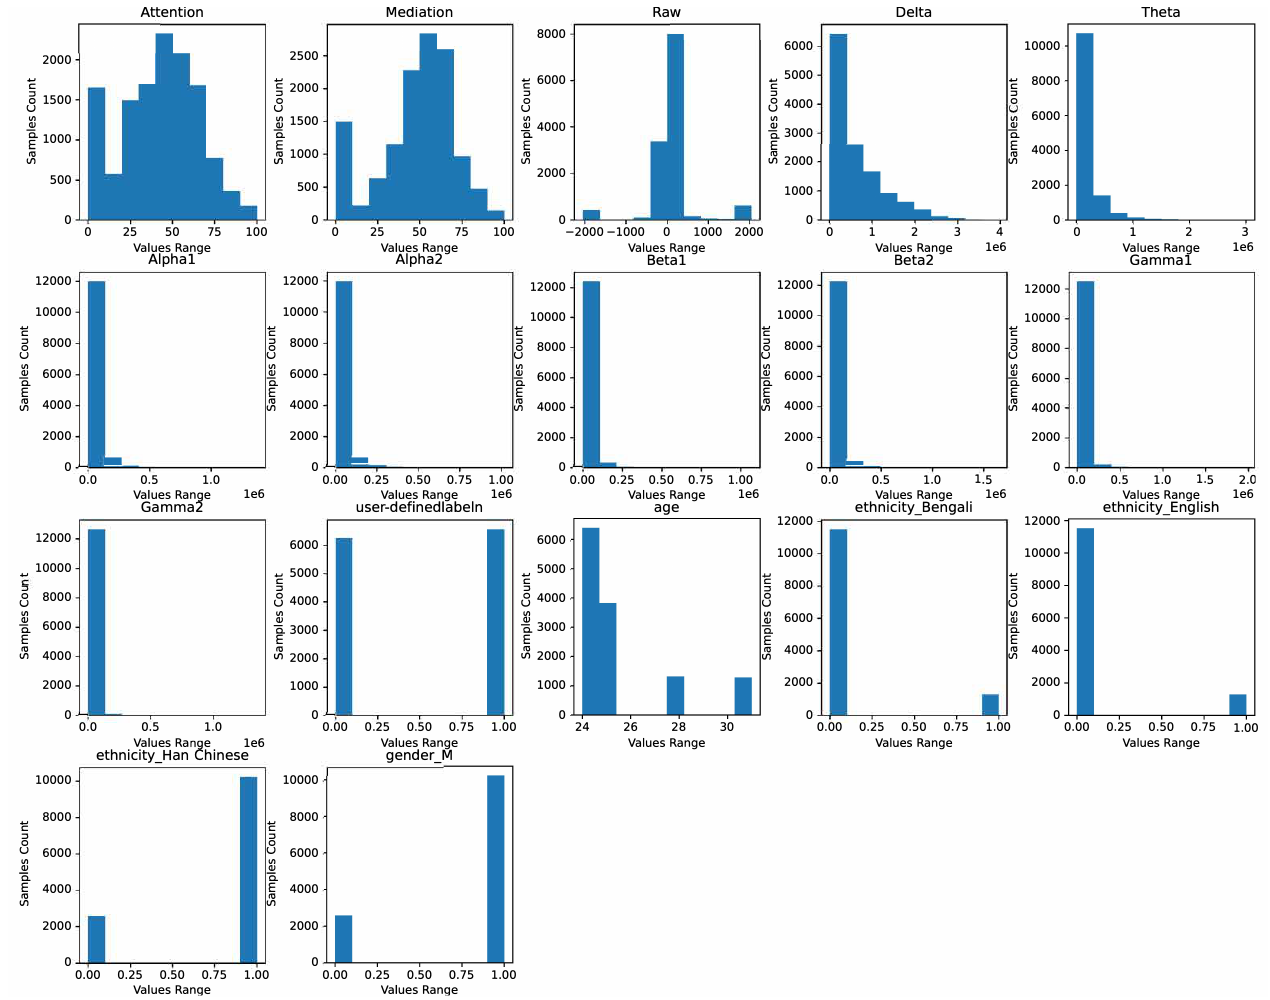
Figure 2. Histogram of EEG dataset features. Table 4. Sample of